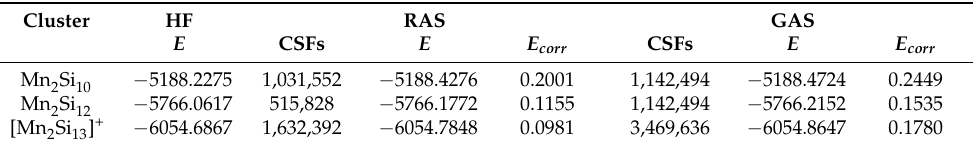
Si , Mn Si , 2 10 2 12